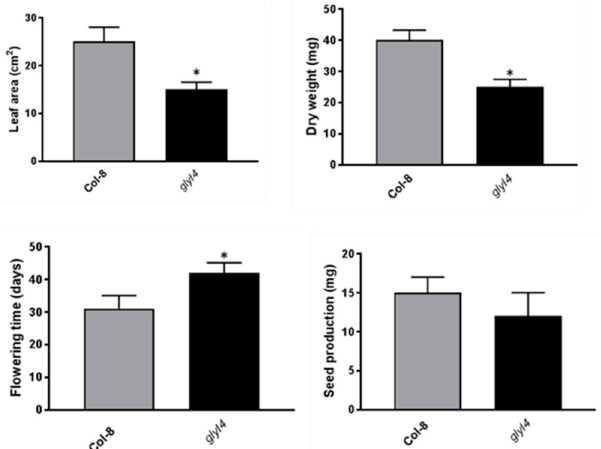
Figure 4. Fitness parameters of Arabidopsis Col-8 and glyI4 . Leaf area (cm 2 ), dry weight (mg), flowering time (days), and seed production (mg), per plant, were analyzed in Col-8 and glyI4 plants. Error bars represent SEM. Asterisk indicates a statistically significant difference between glyI4 and Col-8 (t-test; * p < 0.05, n = 15). The experiments have been repeated three times with similar results.